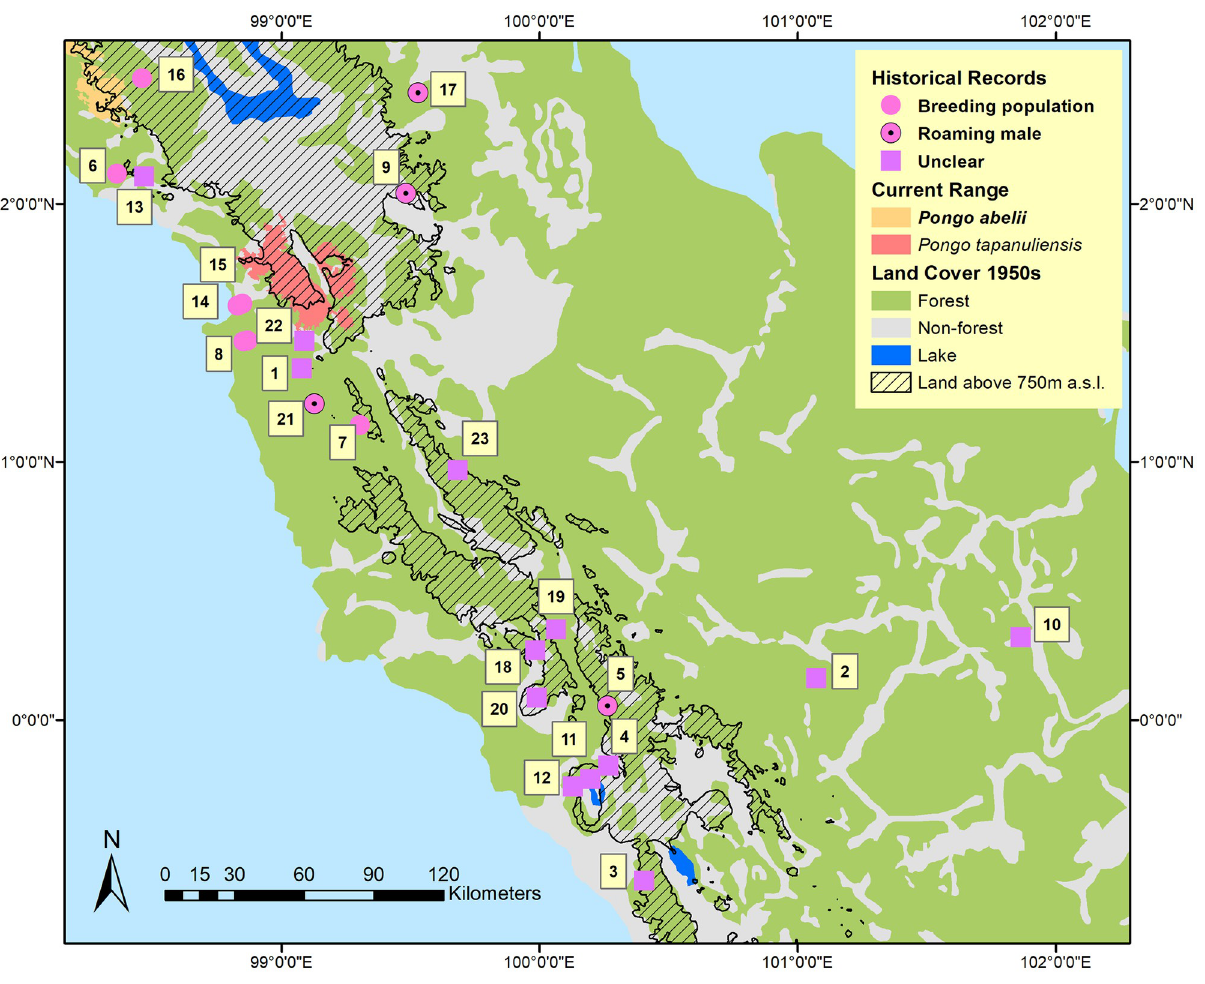
Fig 2. Map showing points where orangutans were historically reported, land above 750m, and the forest cover in 1950 before large-scale commercial forest exploitation began. Reprinted from [26] under a CC BY license, with permission from PT Balai Pustaka, original copyright